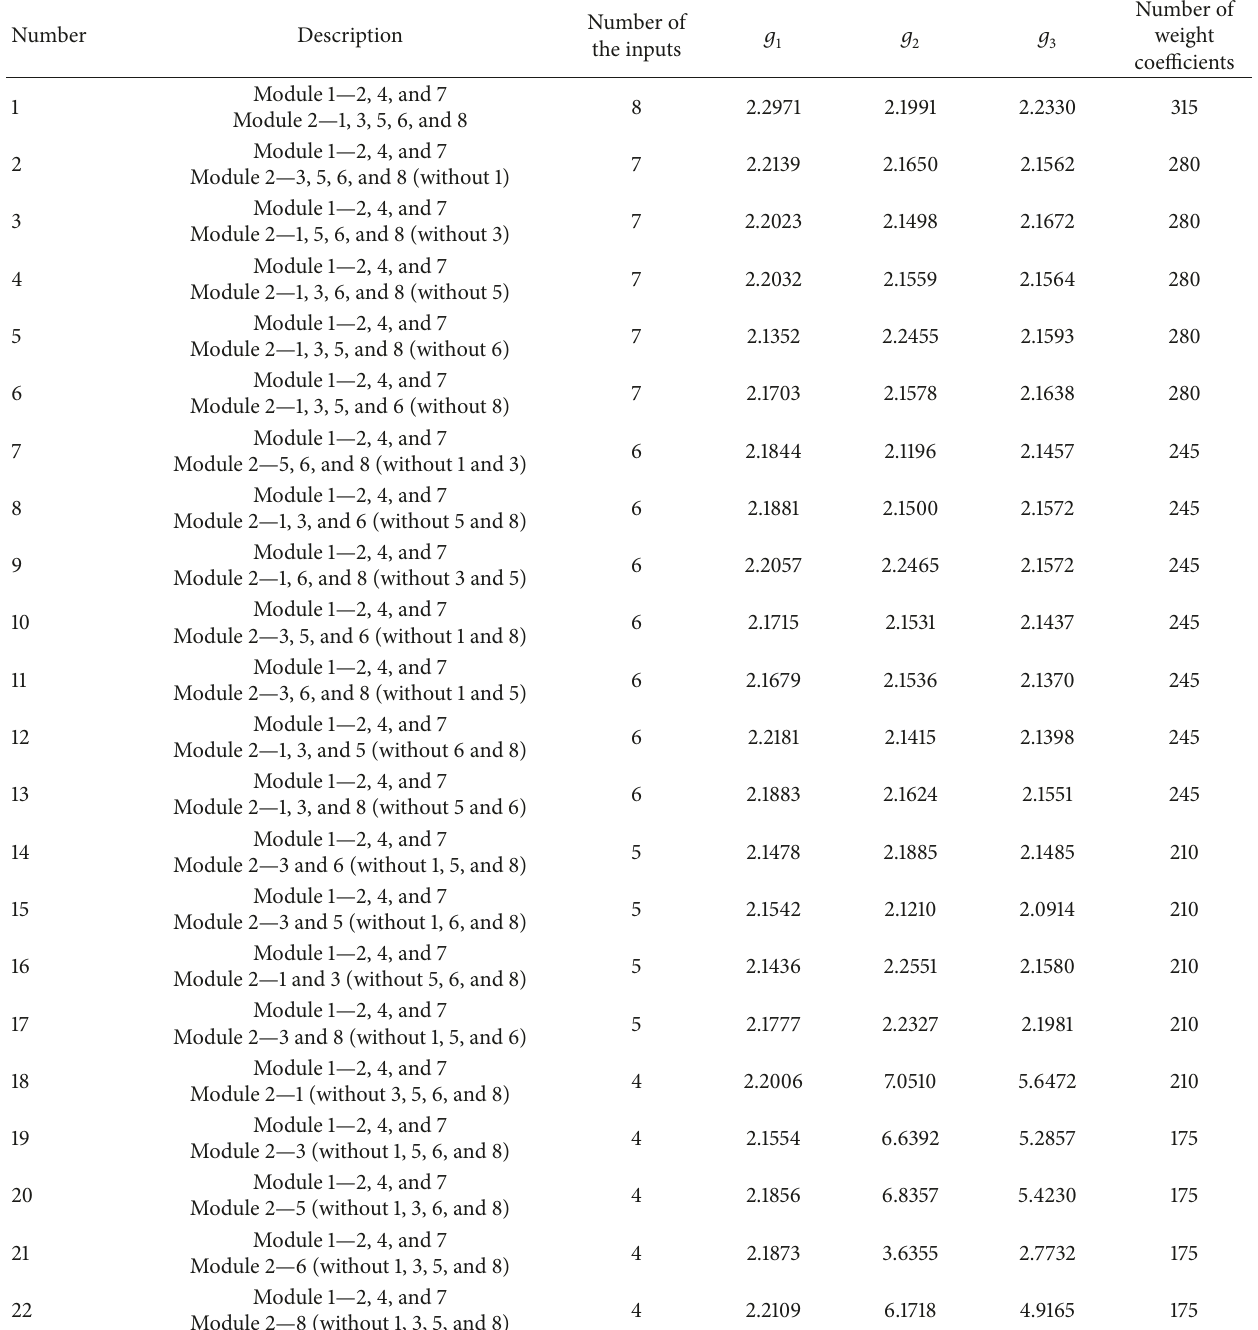
Table 4: Results from the